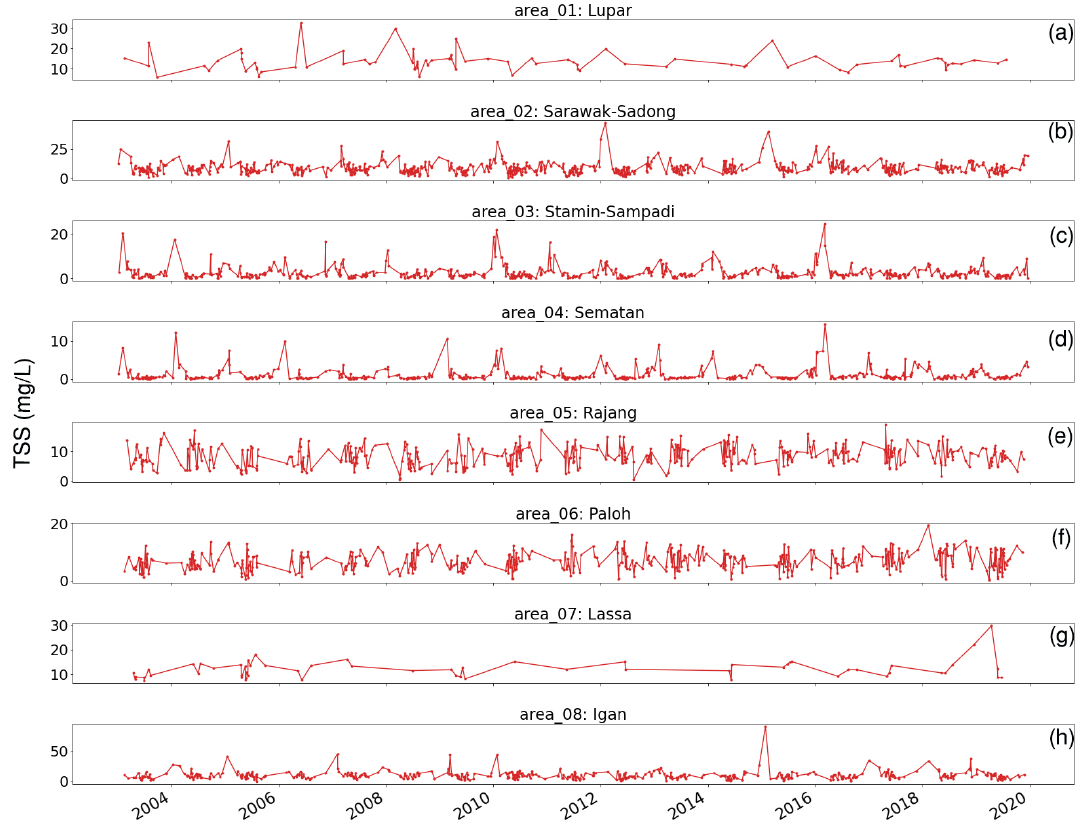
Figure 11. Graphs of daily TSS estimates (mgL − 1 ) recorded at eight river mouth points from 2003 to 2019. The presentation of each river mouth is as follows: (a) area_01, (b) area_02, (c) area_03, (d) area_04, (e) area_05, (f) area_06, (g) area_07, and (h) area_08. Note the different TSS scales in each